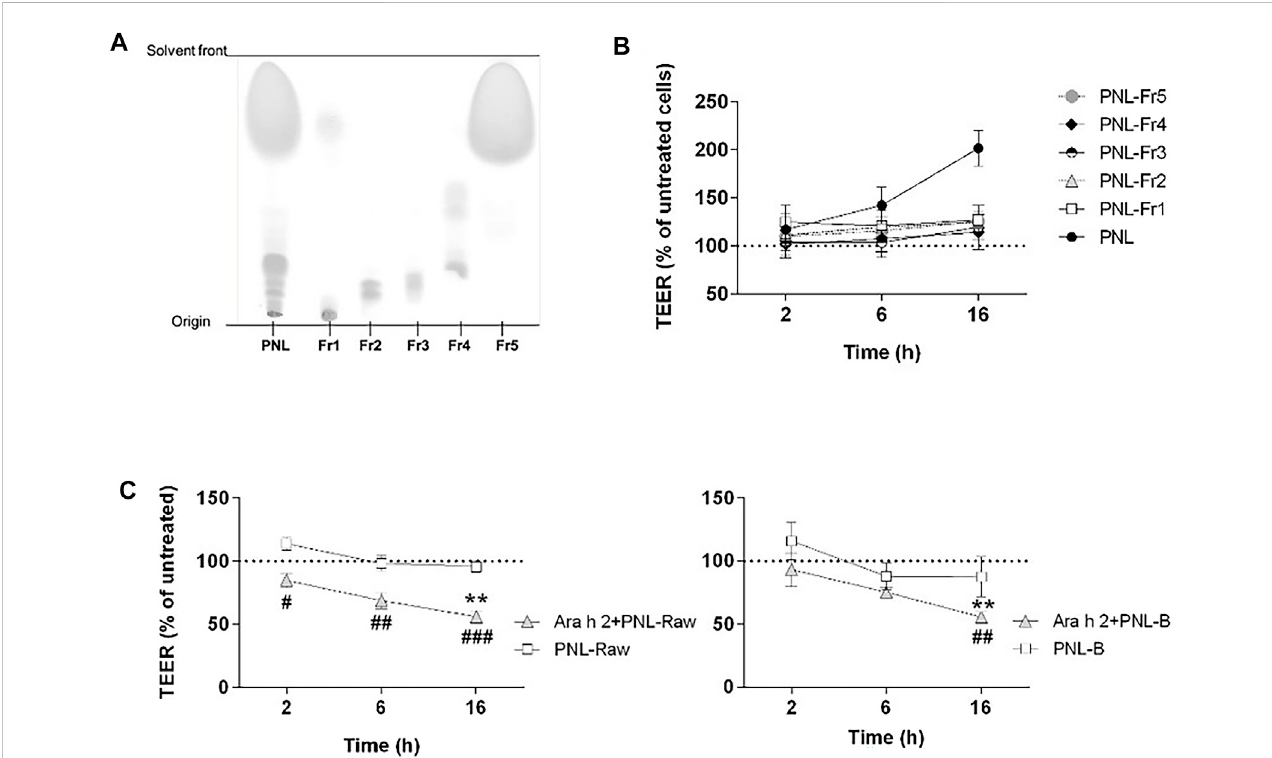
FIGURE 6 Effect of PNL fractions and PNL-preparations on the TEER of 16HBE14o- cell monolayers. (A) Thin-layer chromatography showing PNL and the PNL- fractions (Fr1, Fr2, Fr3, Fr4, and Fr5). (B) PNL and the individual PNL-fractions were applied to the apical compartments of cell monolayers and TEER was measured after 2, 6, and 16 h. Data of three experiments (mean ± SD) are presented as the percentage of the TEER value of untreated cells, indicated by a dashed line. (C) 16HBE14o- cell monolayers were stimulated apically with PNL isolated from raw (PNL-Raw) and boiled (PNL-B) peanuts ± Ara h 2. TEER was measured after 2, 6, and 16 h, and results are reported as percentage of TEER of untreated cells (dashed line). Data represent the mean ± SD of two experiments. p < 0.05, p < 0.01, p < 0.001. (#) indicates signi fi cance between Ara h 2 + PNL (Raw or B) vs. PNL (Raw or B) alone; (*) indicates signi fi cance vs. untreated